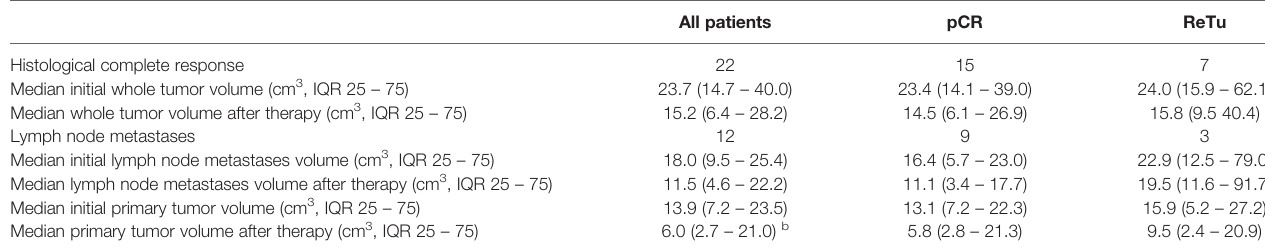
TABLE 1 | Response rate and tumor volume at baseline and follow up for all patients, pathologic complete response (pCR) group and residual tumor (ReTu) group.